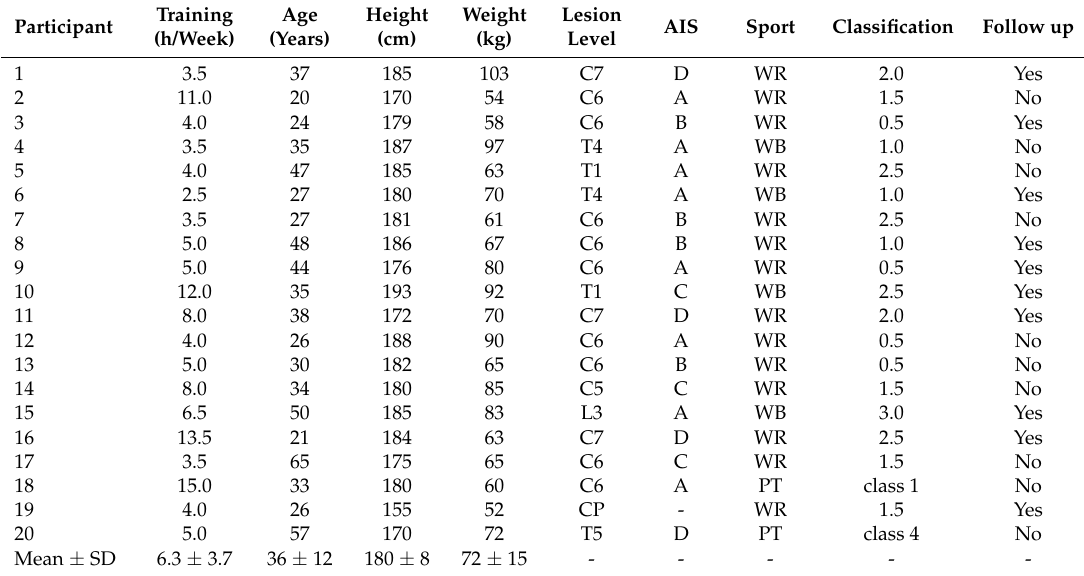
Table 1. Participants’